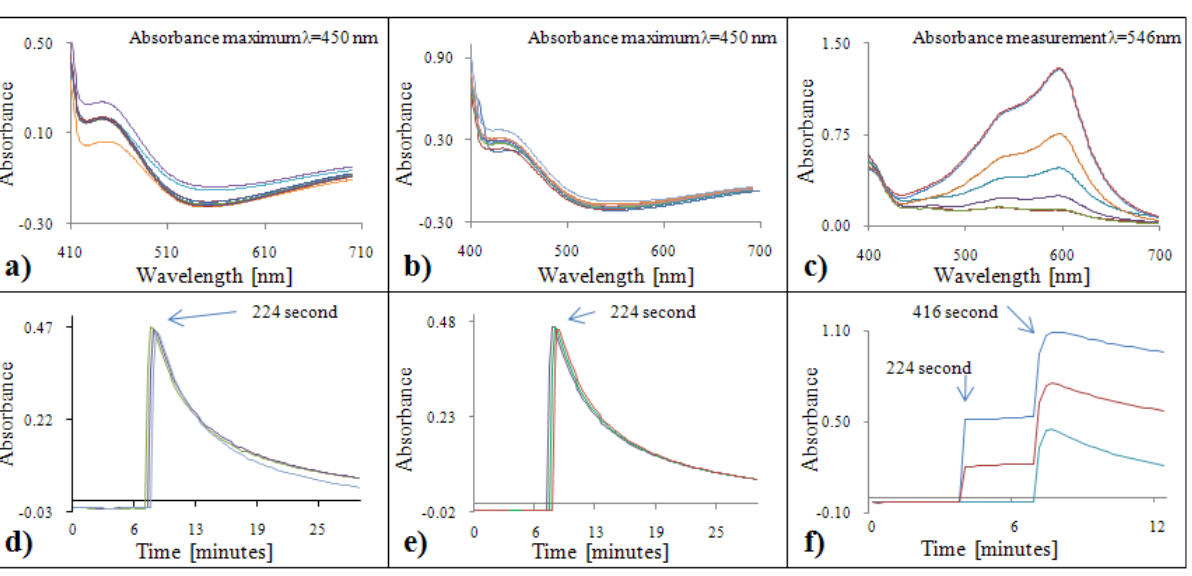
with gallic acid (c) , Trolox ® (d) 5